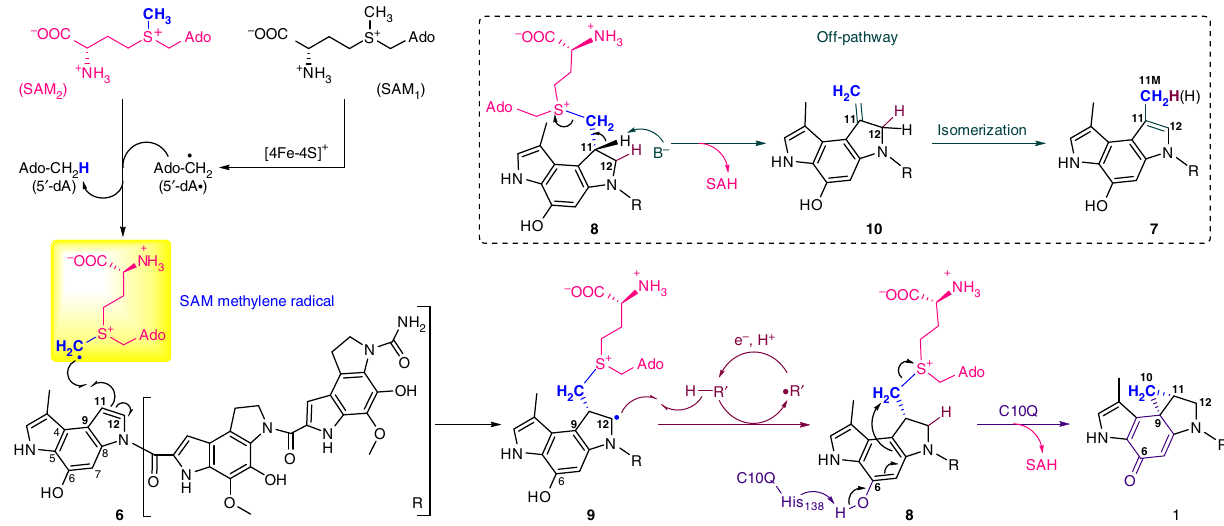
Fig. 5 Proposed mechanism of the cyclopropanation process. Upon dithionite reduction, the [4Fe-4S] 2 + from the HemN-like radical SAM enzyme is converted to [4Fe-4S] + , which triggers the reductive cleavage of the fi rst molecule of SAM 1 to yield a highly reactive dAdo radical. Then, the dAdo radical abstracts a hydrogen atom from the methyl group of the second molecule of SAM 2 . A SAM methylene radical is thus produced and then adds to the C-11 position of the substrate 6 to generate a radical intermediate 9 . The carbon-centered radical at C-12 in 9 abstracts a solvent-exchangeable proton to produce the intermediate 8 . Subsequently, the His-138 residue from C10Q likely functions as a critical base and deprotonates the phenolic hydroxyl group (C-6) of 8 , which induces the intramolecular S N 2 cyclopropanation to yield 1 with elimination of SAH as a co-product. On the other hand, the intermediate 8 may be non-enzymatically converted to the intermediate 10 containing an exocyclic double bond via release of SAH, followed by rapid and thermodynamic driving isomerization to give a methylated off-pathway compound